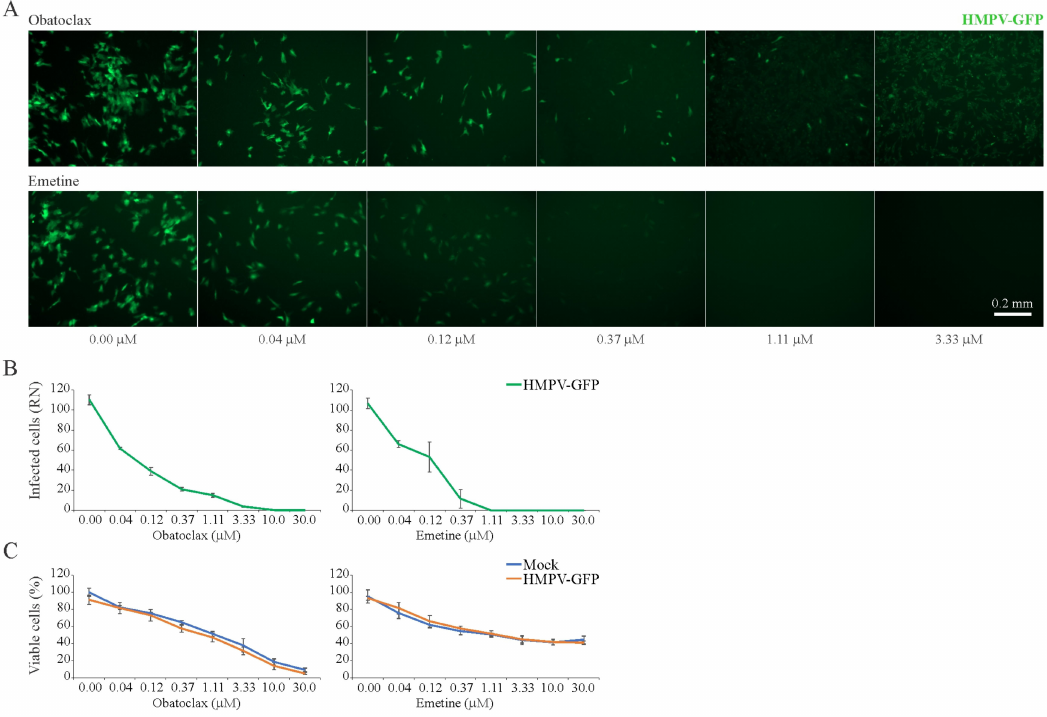
Figure 6. E ff ect of obatoclax and emetine on metapneumovirus (HMPV)-mediated green fluorescent protein (GFP) expression and on the viability of mock- and virus-infected RPE cells. ( A , B ) RPE cells were treated with increasing concentrations of a compound and infected with HMPV-GFP (moi, 0.1). After 96 h, the cells were imaged and fluorescence intensity was quantified (Mean ± SD; n = 3). ( C ) Cell viability was determined with the CTG assay (Mean ± SD; n =